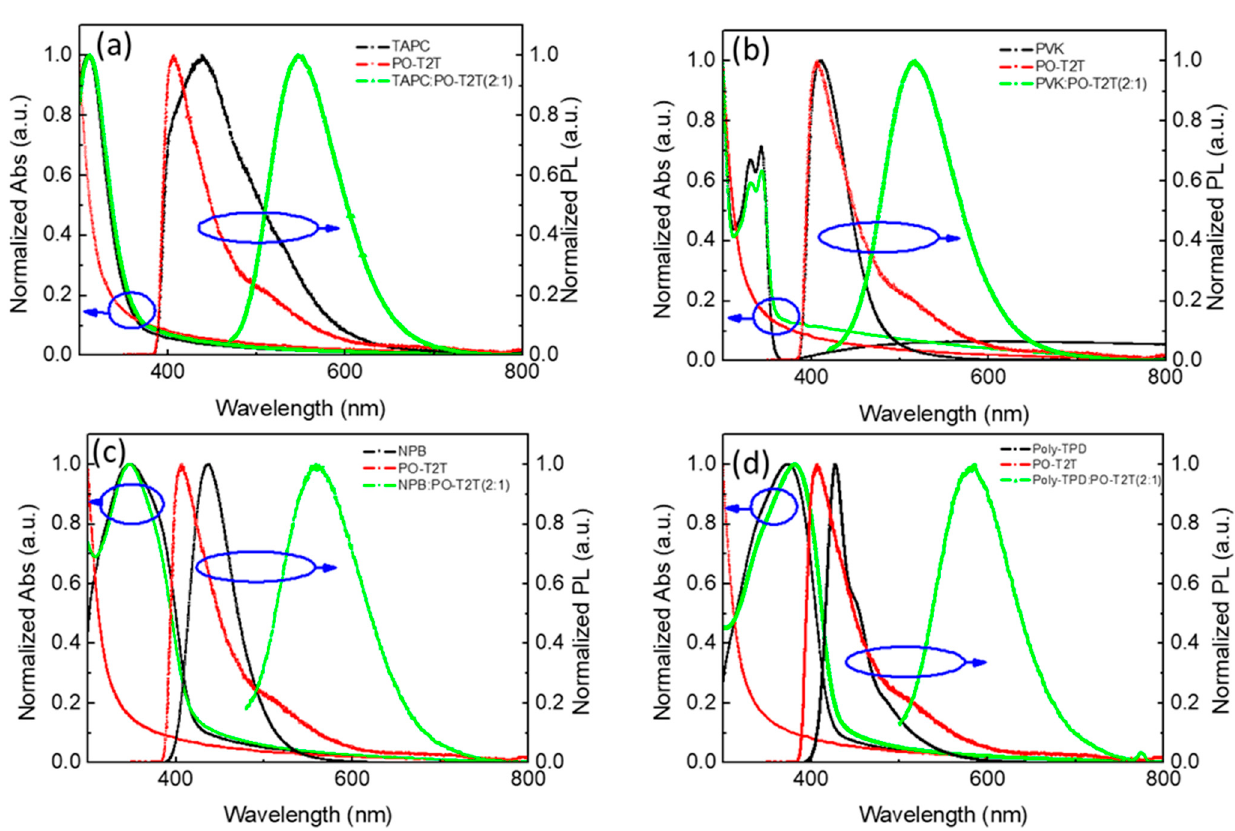
Figure 2. Absorption and photoluminescence (PL) spectra of donors, acceptor, and exciplexes obtained in solid films in air (for PL, λ ex = 330 nm): ( a ) TAPC:POT2T, ( b ) PVK:POT2T, ( c ) NPB:POT2T, and ( d ) Poly-TPD:POT2T.